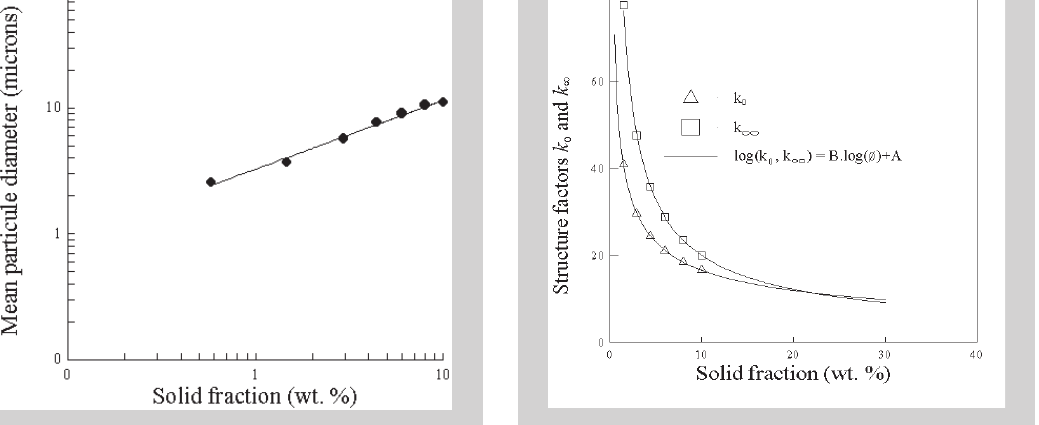
Figure 7 (left): Mean diameter of the aggregates calculated with Eq. 7 versus bentonite concentration (wt. %). Figure 8 (right): Structural factors k0 and k • versus bentonite concentration (wt. %).